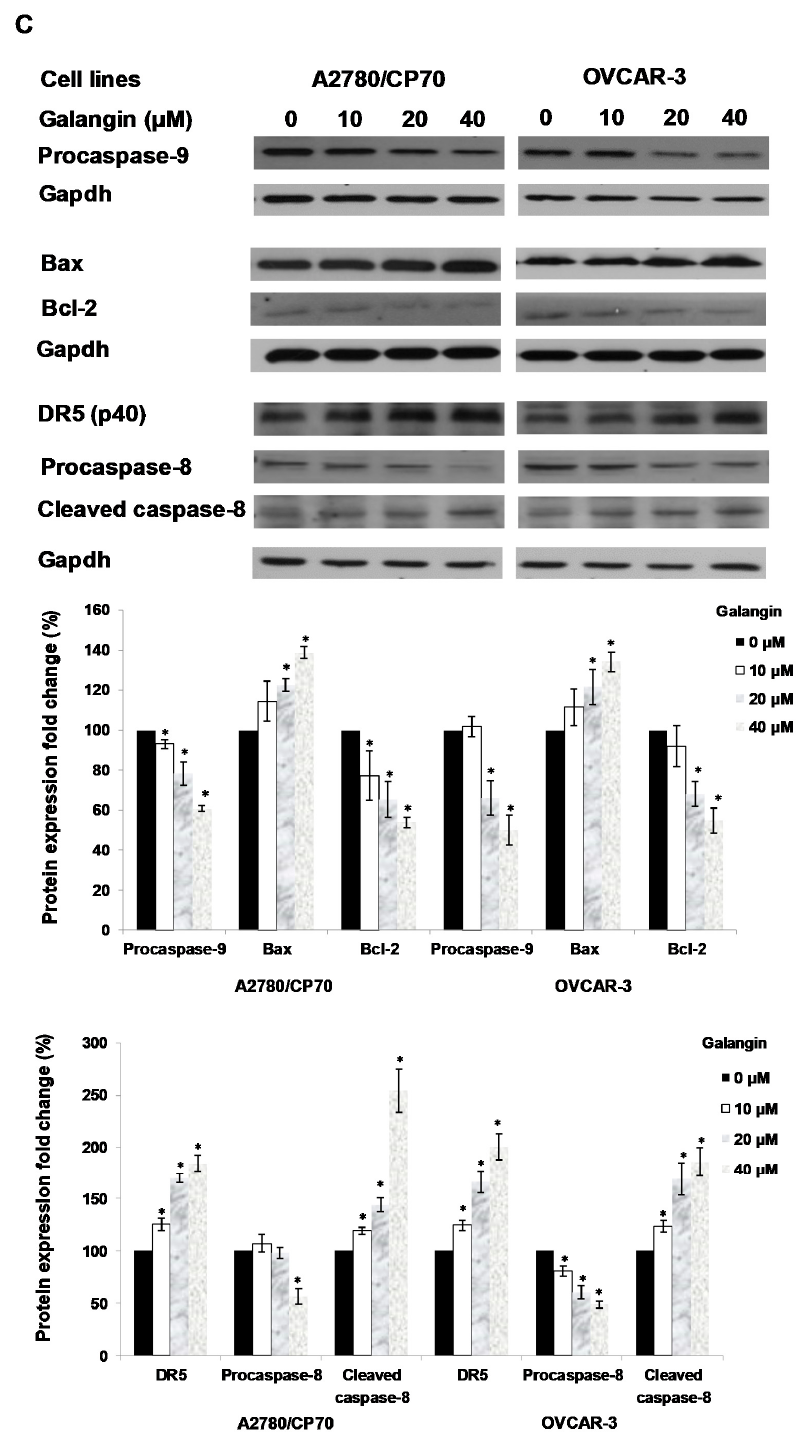
Figure 5. Pathways of galangin-induced apoptosis in A2780 / CP70 and OVCAR-3 cells. ( A ) After being treated with galangin for 8 h, the caspase-3 / 7 enzymatic activities in A2780 / CP70 and OVCAR-3 cells were investigated using a Caspase-Glo 3 / 7 Assay kit. ( B ) Galangin down-regulated the levels of procaspase-3, -7, and up-regulated the levels of cleaved caspse-3, -7 and PARP-1 in A2780 / CP70 and OVCAR-3 cells. ( C ) Galangin down-regulated the levels of procaspase-8, -9 and Bcl-2, and up-regulated the levels of cleaved caspse-8, matured DR5 (p40) and Bax in A2780 / CP70 and OVCAR-3 cells. Protein bands were quantitated, normalized to corresponding Gapdh bands and expressed as percentages of control. * p < 0.05 as compared to the